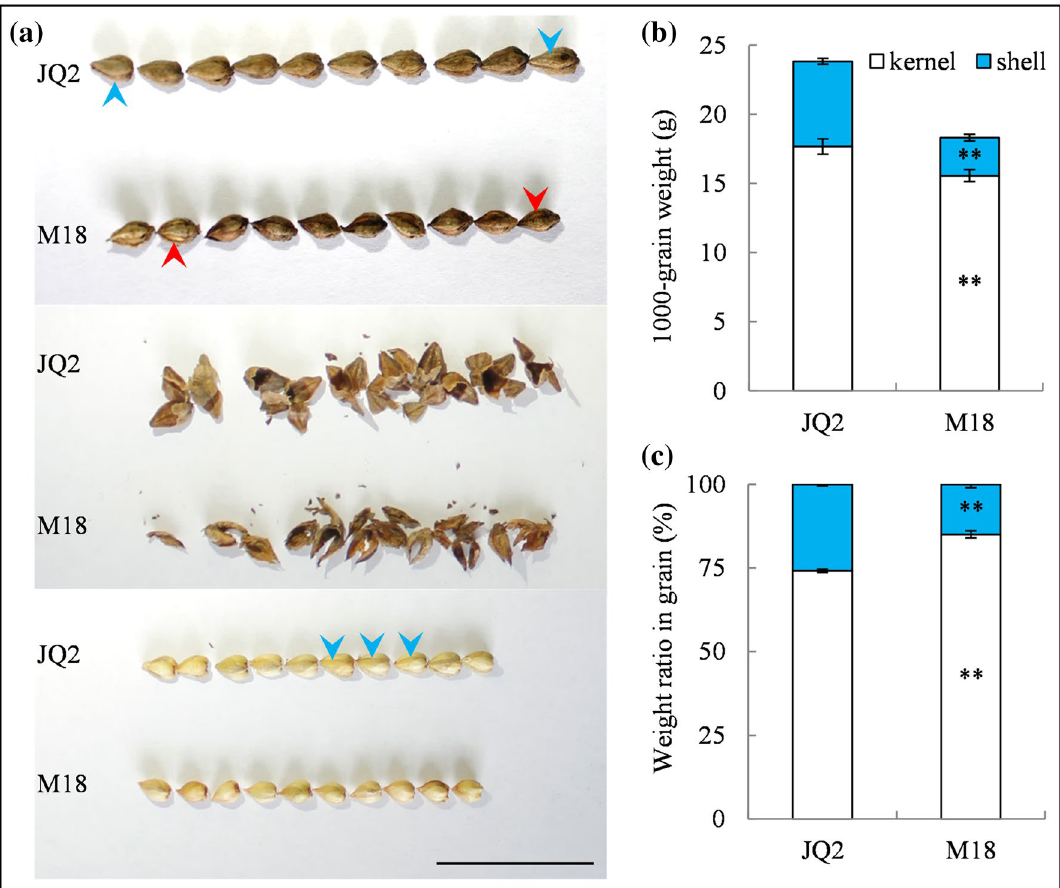
Figure 1. Seed phenotype ( a ), grain weight ( b ) and weight ratio of kernel and shell ( c ) in grains of Tartary buckwheat. The photo was spliced by PowerPoint in Microsoft Office 2003. Blue arrows point to the longitudinal furrows of CTB seed, and red arrows point to the cracked shell of RTB seed. JQ2 indicates Jinqiaomai 2, M18 indicates Mikuqiao 18. Bar = 2 cm. * and ** indicate significant differences at 0.05 and 0.01, respectively, according to independent samples t -test (n =